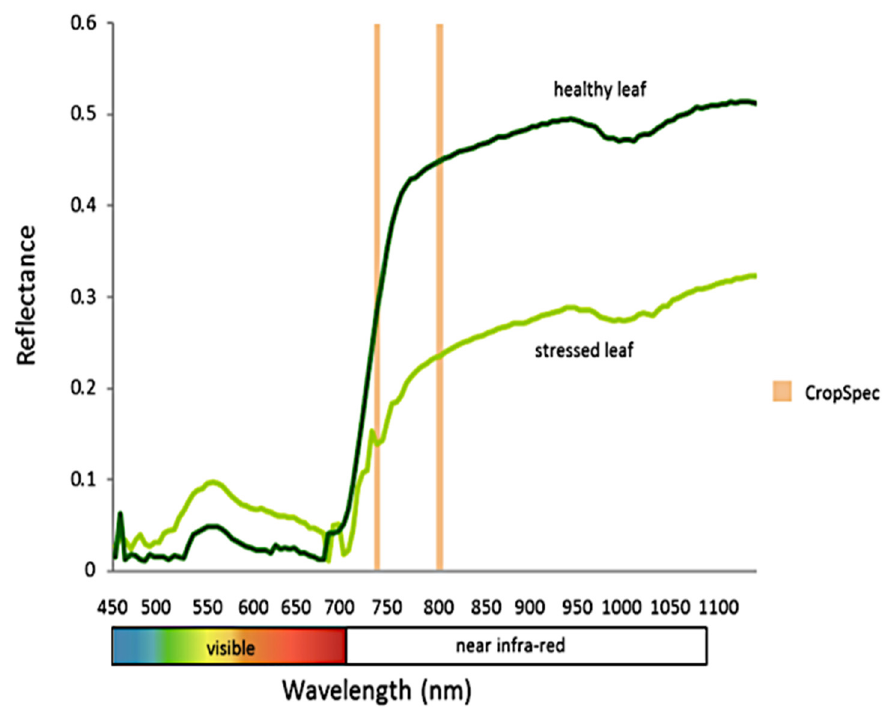
Figure 3. Spectral reflectance for healthy and stressed leaf in visible and NIR wavelength [59].